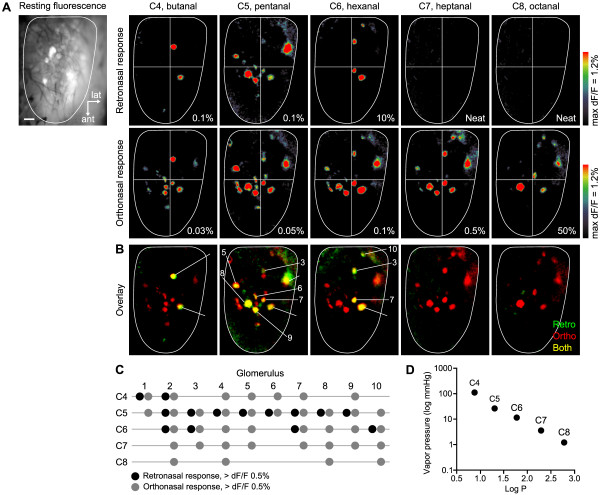
Glomerular activity patterns of aliphatic aldehydes presented by the retronasal or orthonasal pathway. A: Response maps evoked by a homologous series of aliphatic aldehydes (C4 – C8) from a single mouse. The left-most panel shows the resting fluorescence image. Scale bar = 200 μm. Retronasal stimuli were delivered for 30 s at 300 ml /min (upper panels). Orthonasal stimuli were delivered for 10 s at 150 ml /min (lower panels). Percent dilutions in mineral oil are given in each panel. B: Overlay of retronasal and orthonasal response maps expressed in different color channels to indicate glomeruli responding to one or both airflow pathways (retronasal only: green, orthonasal only: red, both: yellow). C: Dot-plot representation of responses of the glomeruli numbered in panel B. Dots correspond to > 0.5% increase in response amplitudes. Black and gray filled circles show retronasal and orthonasal responses, respectively. D: Vapor pressure and log P of test aldehydes (log P = index of hydrophobicity).